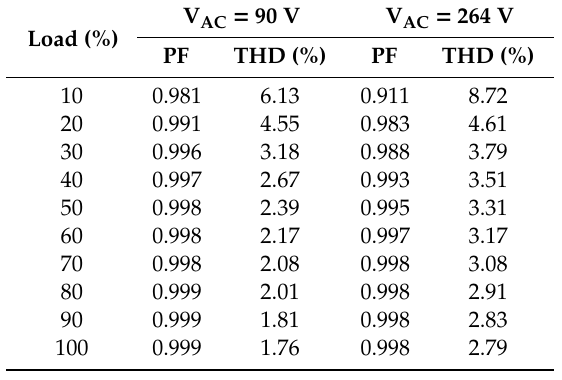
Table 2. The measured total harmonic distortion (THD) and power factor (PF) at the line voltage of 90 V and 264 V.